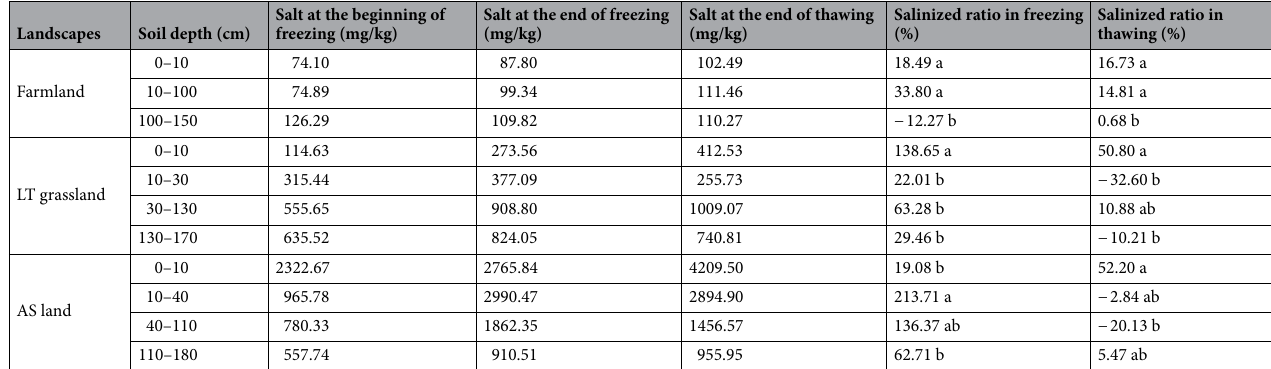
Table 3. Soil salinized ratio of farmland, LT grassland and AS land in freezing period and thawing period. Letters represent multiple comparison results and the dissimilar letter indicate a significant difference ( P < 0.05).